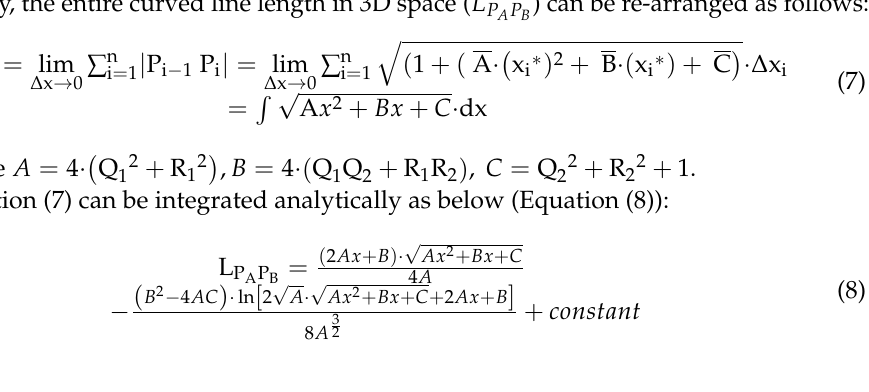
Figure 3. Tension distribution estimation model.